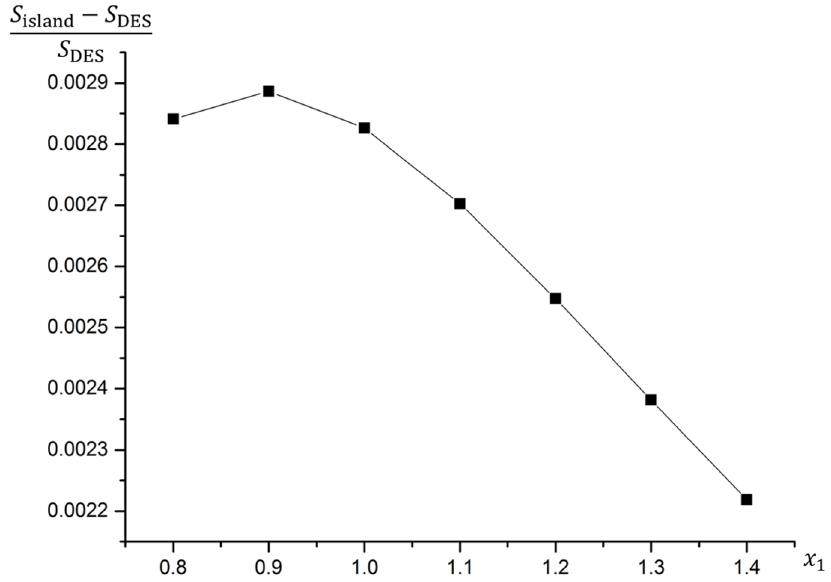
Figure 12 . Entropy difference divided by S DES with respect to x 1